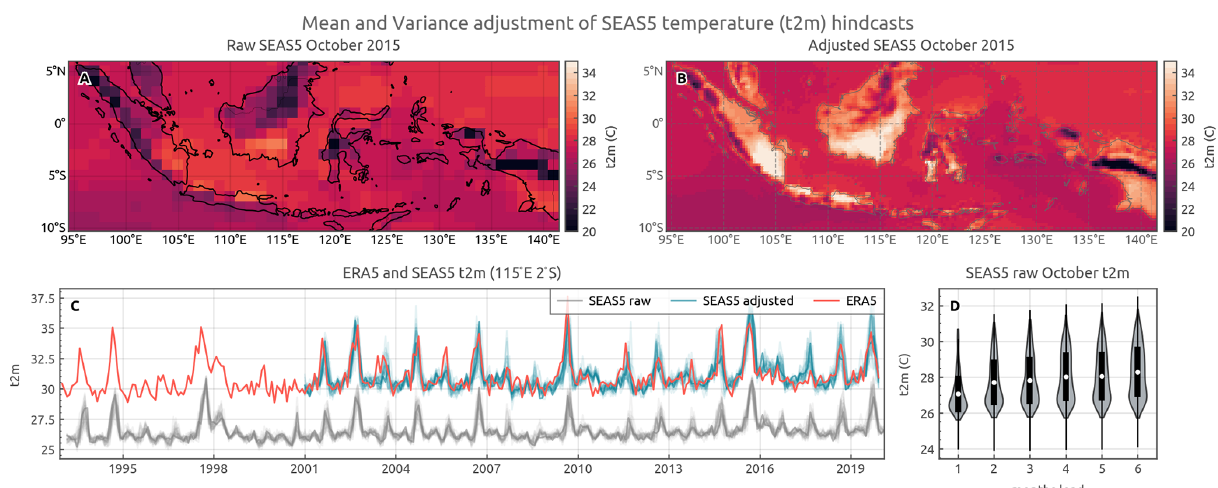
Figure 3. Illustration of mean and variance adjustment applied to raw SEAS5 ensemble member forecasts. (a) Raw SEAS5 member of 1 for temperature at 2m (t2m) for October 2015 with a lead time of 2 months. (b) October 2015 mean-and-variance-adjusted 2m temperature of the same SEAS5 member based on calibration against overlapping 1993–2019 series between the ERA5 reanalysis and SEAS5 forecasts. (c) SEAS5 ensemble member raw and bias-adjusted and ERA5 2m temperature at the 115 ◦ E, 2 ◦ S location for the 1993–2019 period (bias- corrected SEAS5 is only shown for the study period 2002–2019). (d) Mean SEAS5 member 2m temperature for all October months in the record for different lead times, showing ensemble mean drift (warming in this case) and increasing